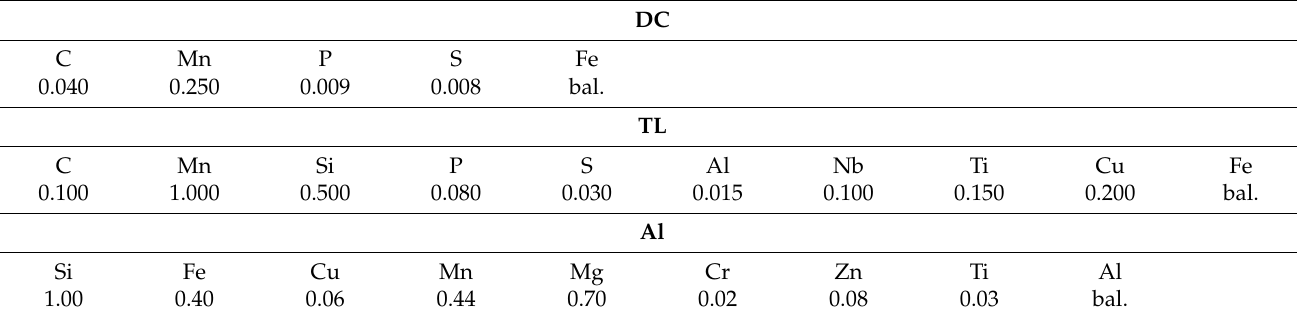
Table 2. Chemical composition of materials, wt.